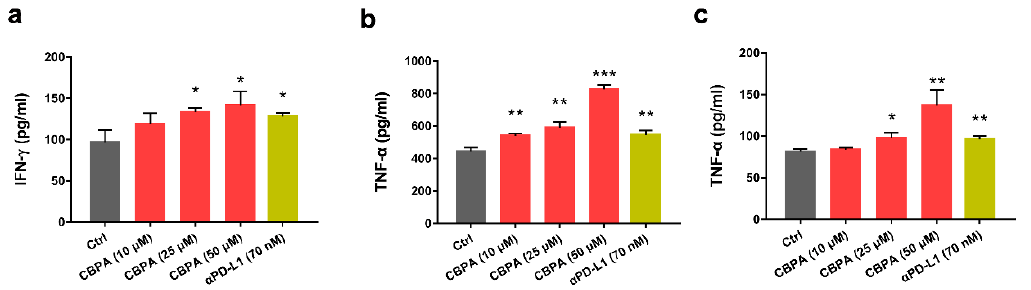
Figure 5. Effects of CBPA on T-cell activity and cytokine level. ( a , b ) CBPA rescued IFN- γ and TNF- α production in CD4 + T-cells co-cultured with hPD-L1-overexpressed HEK293T cells. ( c ) Effects of CBPA on TNF- α secretion from CD4 + T-cells co-cultured with NCI-H1975 cells. Data are shown as means ± SEM, * p < 0.05, ** p < 0.01, *** p < 0.001, unpaired t -test.